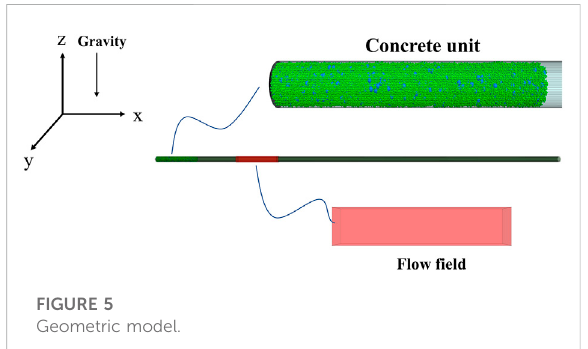
TABLE 3 Aggregate-aggregate contact parameter.